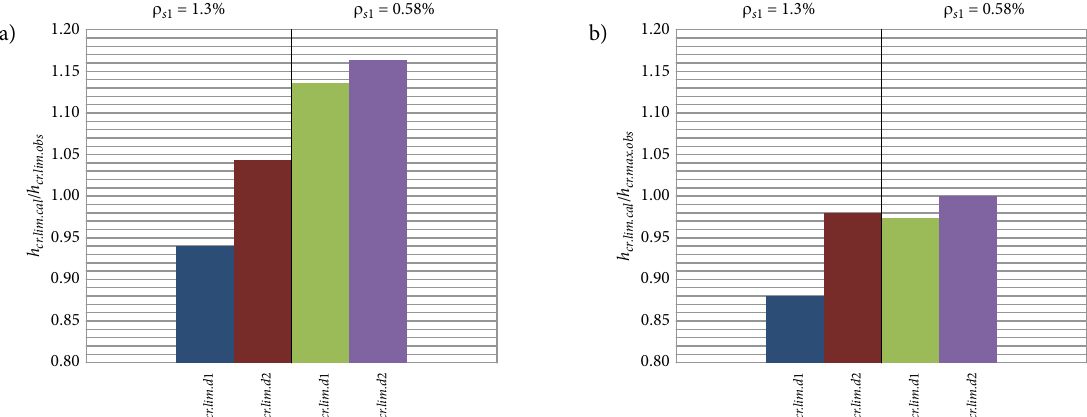
Fig. 12. Comparison of estimated and experimental values of the limit crack depth: a ) the ratio of limit crack depth calculated , when reinforcement stress reached yield strength; by equations (17–18) and experimentally set limit crack depth h cr.lim.obs , b ) the ratio of limit crack depth calculated by equations (17–18) and experimentally set final crack depth h cr.max.obs was when beam’s fracture moment M u2.obs